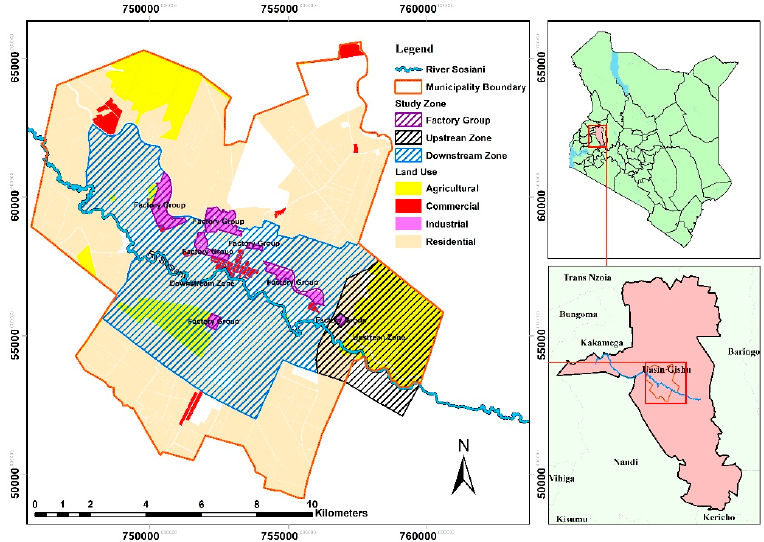
Figure 2. Study area and the selected regions in the area.